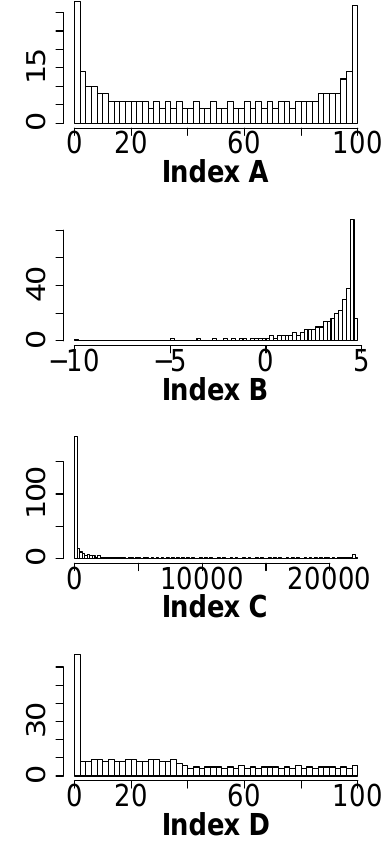
Fig. 3. Frequency distributions of the four hypothetical